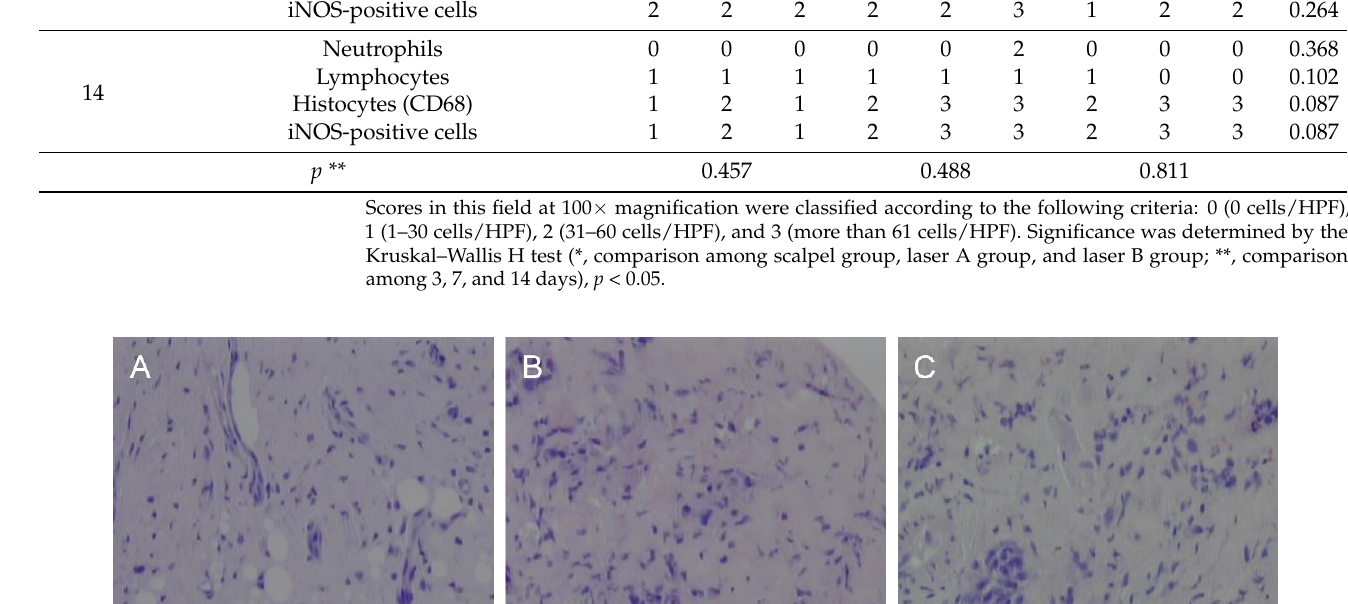
Figure 3. Photos taken at 3 days ( A ), 7 days ( B ), and 14 days ( C ) after surgery; a: steel scalpel, b: laser A group, c: laser B group.